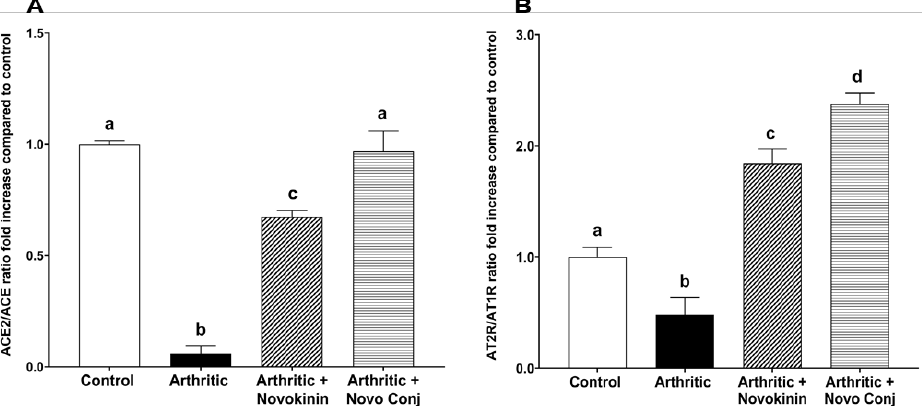
Figure 5. Novokinin conjugate (Novo Conj) increased mRNA expression of ( A ) the ratio of angio- tensin-converting enzyme 2 (ACE2)/angiotensin-converting enzyme (ACE) and ( B ) the ratio of an- giotensin type II receptor (AT2R)/angiotensin type I receptor (AT1R) in cardiac tissues. Mean ± SD ( n =5 or 6). Triplicates samples were run. Data labeled with different letters (a, b, c, or d) indicate a statistical difference between groups where p < 0.05.